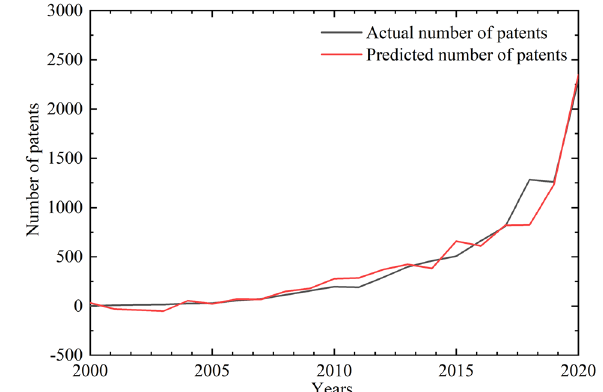
Fig. 6 A line graph of the actual and predicted values of the target variables in the arti fi cial neural network prediction model of the in fl uencing factors of construction enterprises ’ adoption of green development behaviors. The trend of the actual patent number and the predicted patent number curve is roughly the